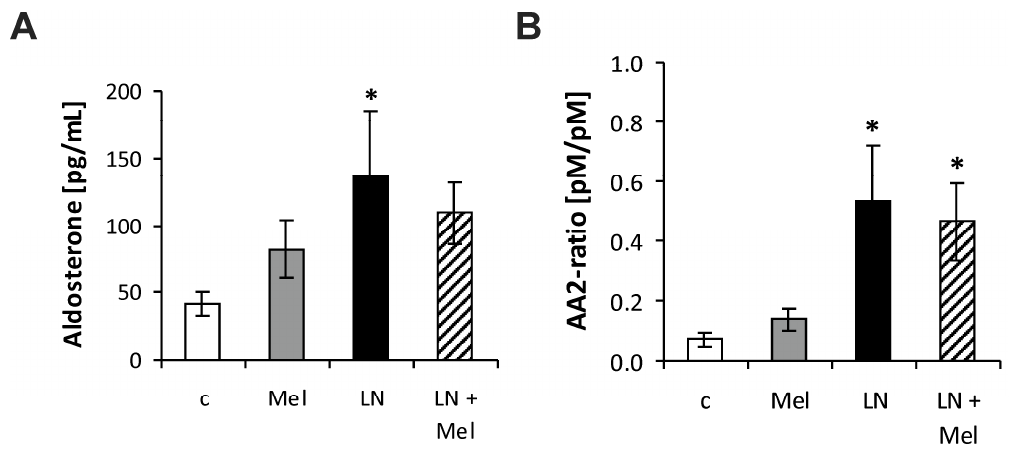
Figure 6. The influence of melatonin (LN + Mel) on the serum level of aldosterone ( A ) and aldosterone/Ang II (AA2) ratio ( B ). Wistar controls (c); L -NAME (LN); melatonin (Mel); n = 6 per group; * p < 0.05 vs. c.